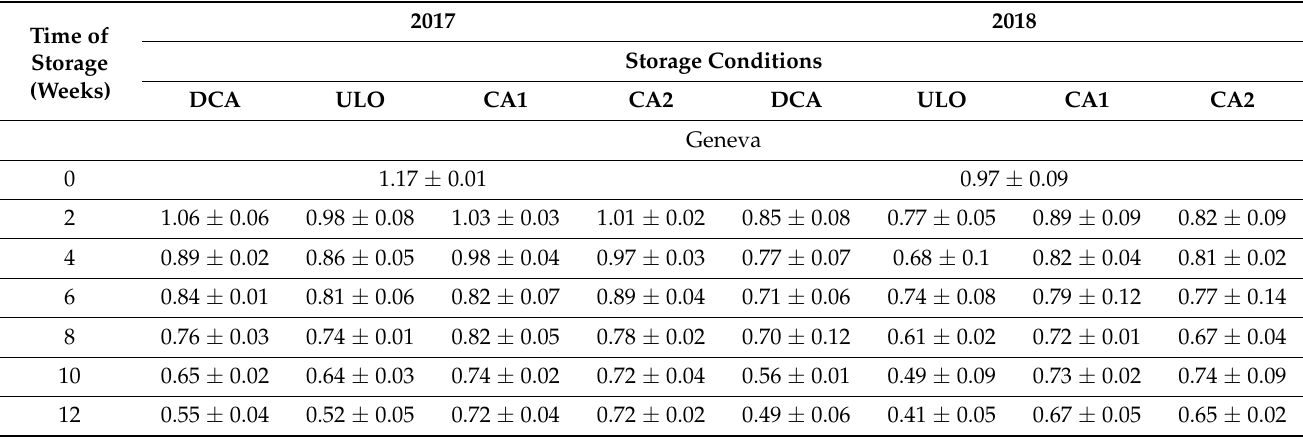
Table 6. Changes in titratable acidity (% citric acid) measured in ‘Geneva’ and ‘Ananasnaya’ minikiwi fruits in the postharvest